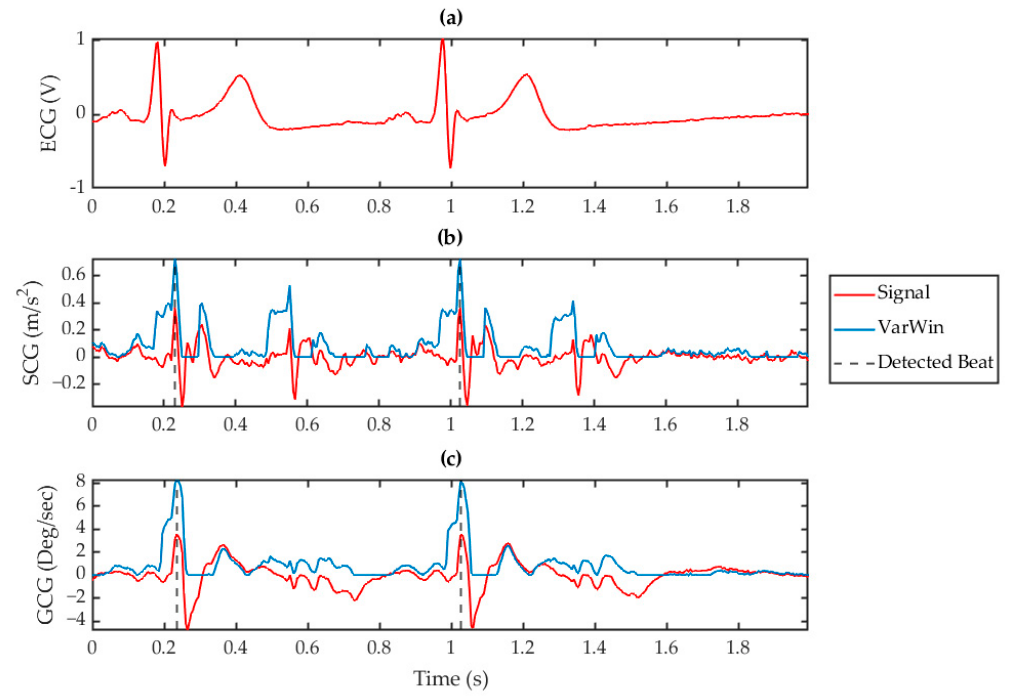
Figure 4. Processed signals for ( a ) ECG, ( b ) SCG (red) with its corresponding VarWin waveform (blue), and ( c ) GCG (red) with its corresponding VarWin waveform (blue) for a 2 s window. The vertical, dashed grey lines indicate the detected peaks using this technique.